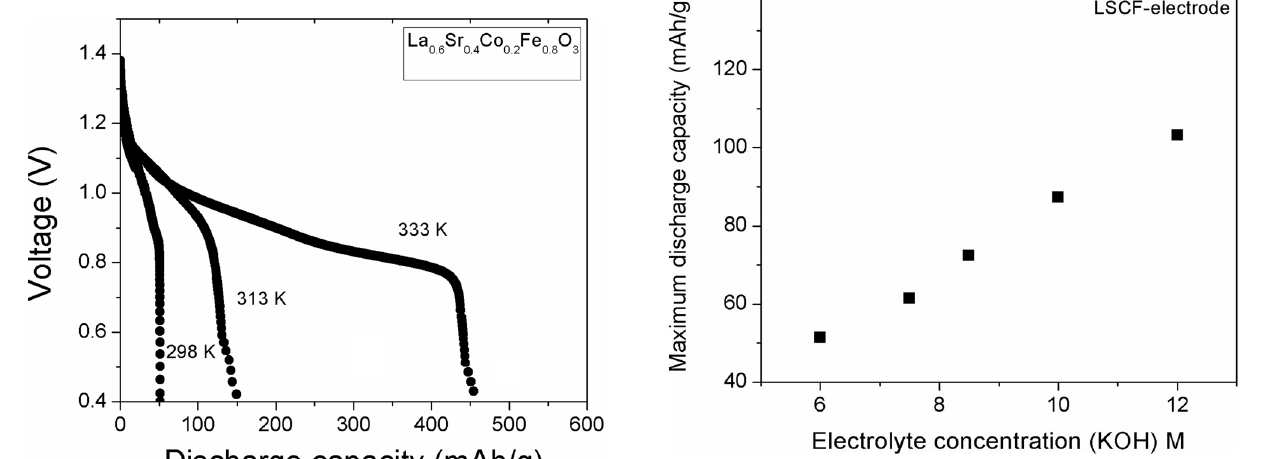
Fig. 5 Maximum specific discharge capacity of the La 0.6 Sr 0.4 Co 0.2- Fe 0.8 O 3 electrode after galvanostatic cycling at various electrolyte concentrations and 298 K. (discharge current density of 125 mA g - 1